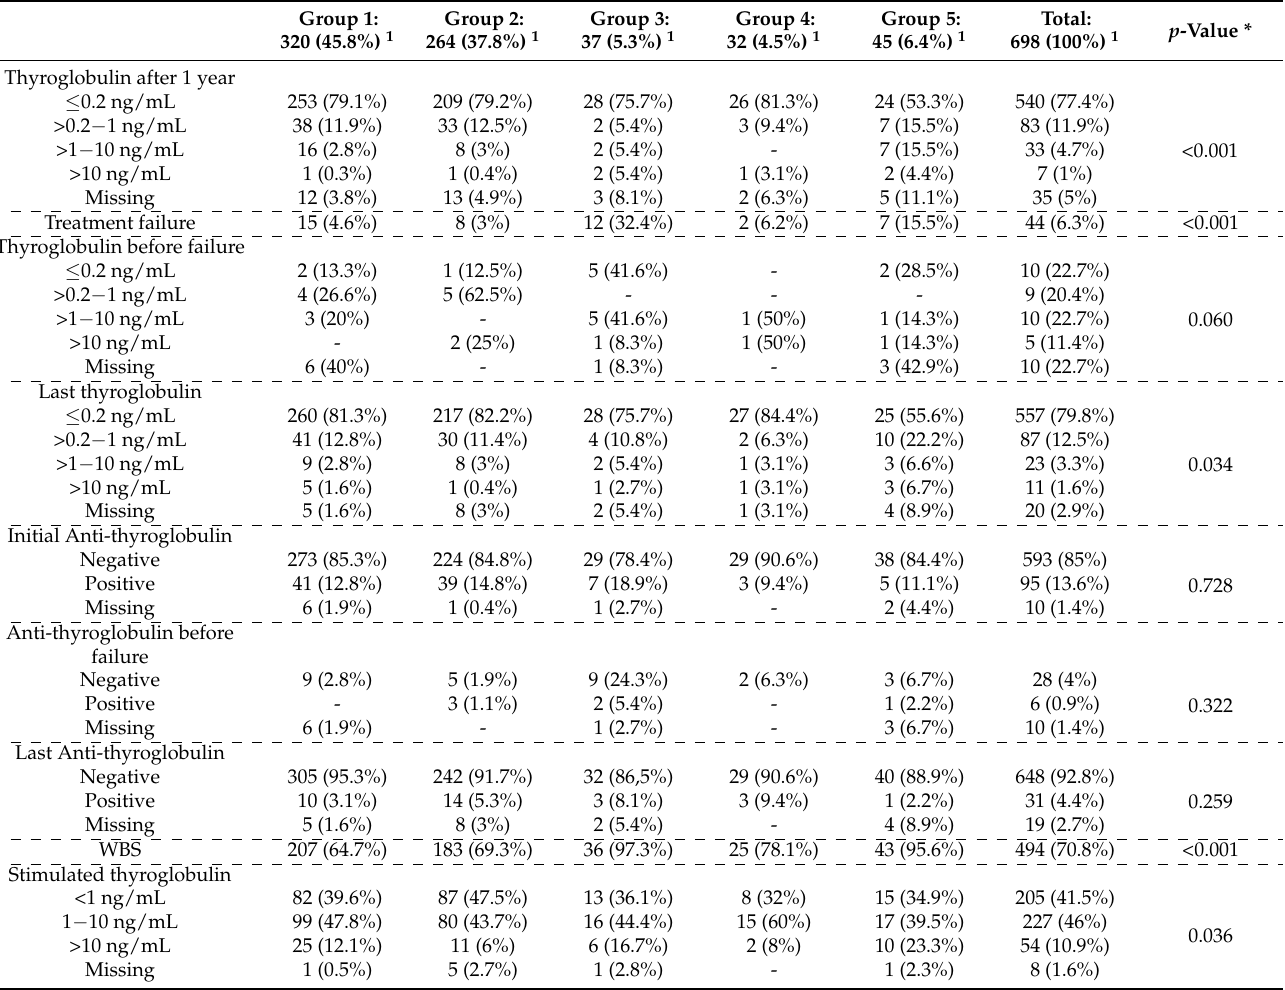
Table 3. Comparison of thyroglobulin and anti-thyroglobulin antibody levels between groups under adequate thyroid stimulation hormone